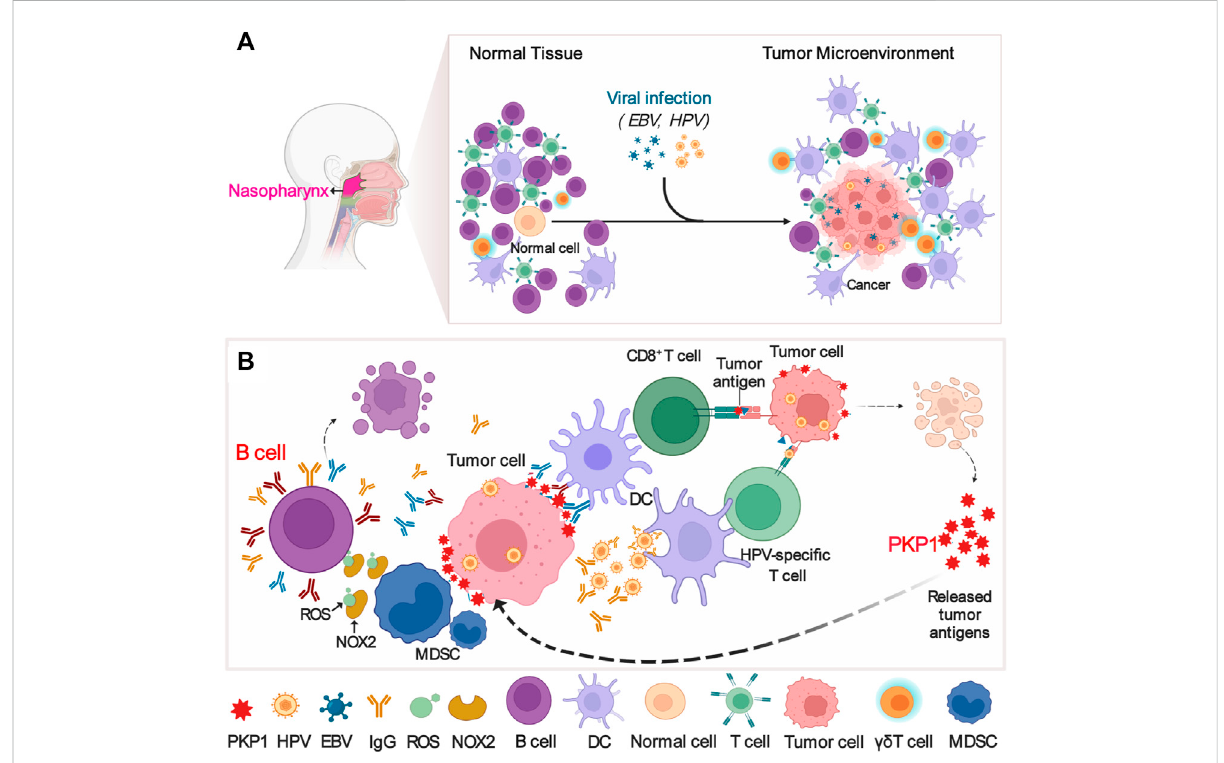
FIGURE 8 PossiblemechanismdiagramoftheinteractionbetweenPKP1andTIL-BsinNPCmicroenvironments. (A) EBVandHPVinfectionresultsinNPC. (B) The interaction between PKP1 and TIL-Bs. TIL-Bs produce IgG to kill tumors, and NPC cells fi ght back. TIL-Bs: tumor-in fi ltrating lymphocyte-B cells. This diagram is only a proposal of the mechanism that warrants further validation. Created with